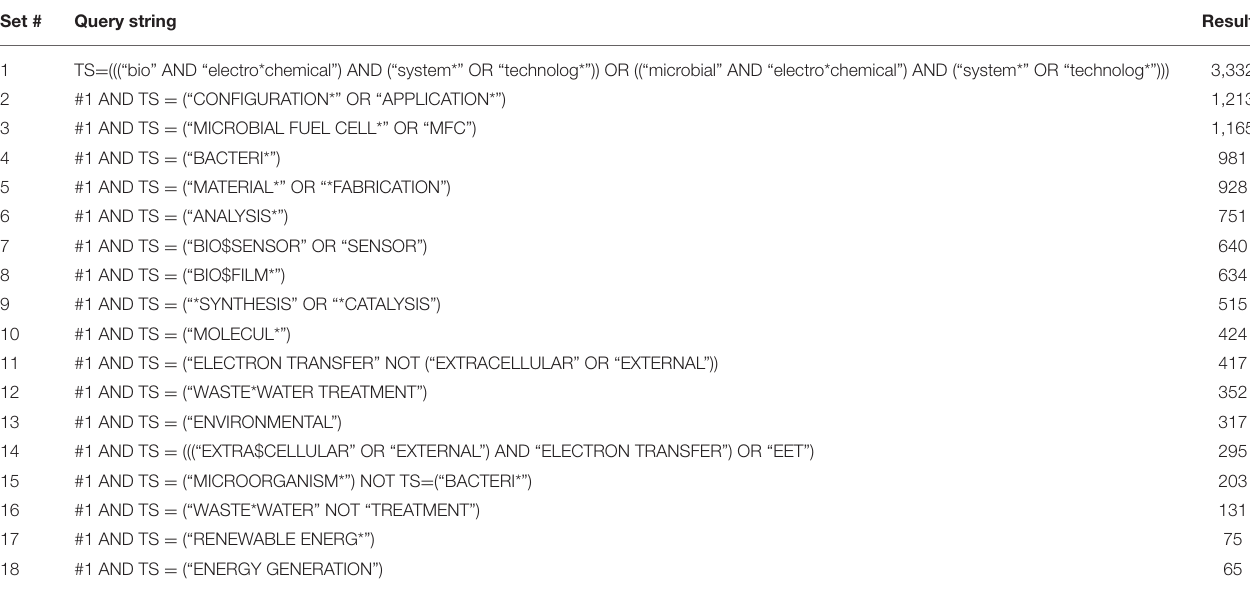
TABLE 4 | Publication results for the different search query strings used in this